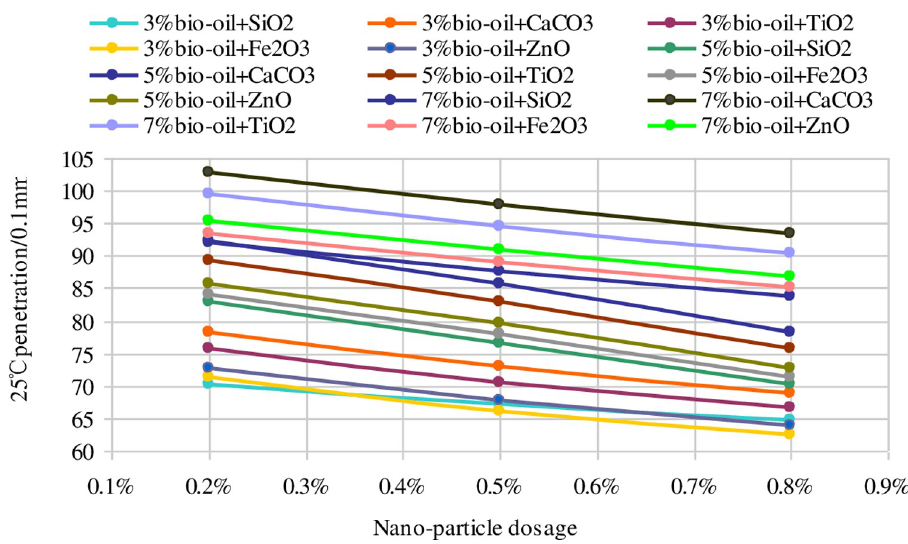
Fig 1. Trend of 25˚C penetration with different nano-particle dosages.